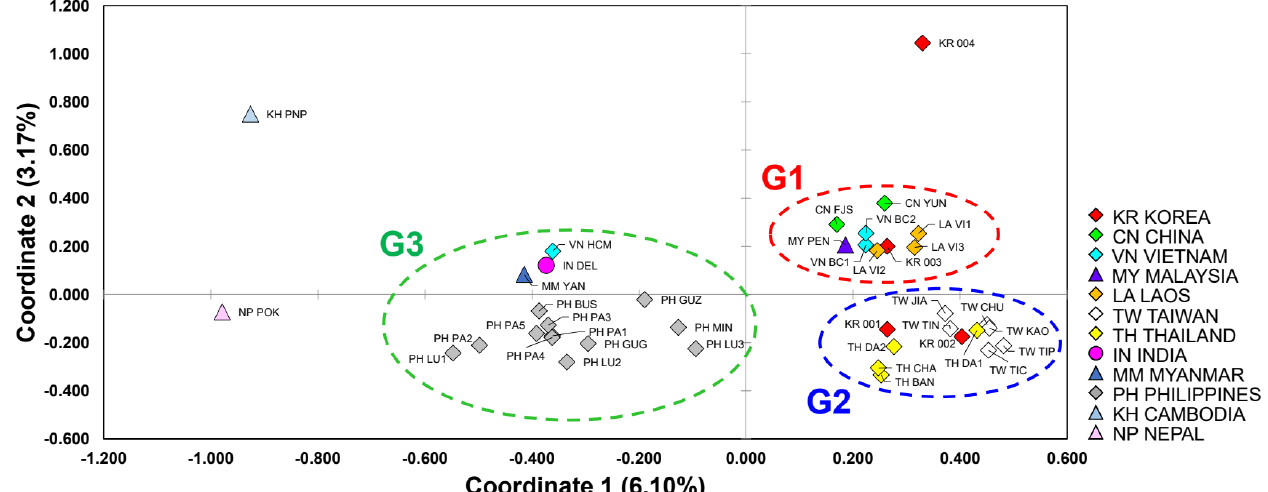
Figure 3. Principal coordinates analysis (PCoA) plotted by microsatellite data from 39 populations of Bactrocera dorsalis from 12 Asian countries by GENALEX. The x -axis is coordinate 1, ranging from −1.20 to 0.60 , and the y -axis coordinate 2, from −0.60 to 1.20. CN SHA was excluded from the analysis because it was located outside due to the effect of null alleles.